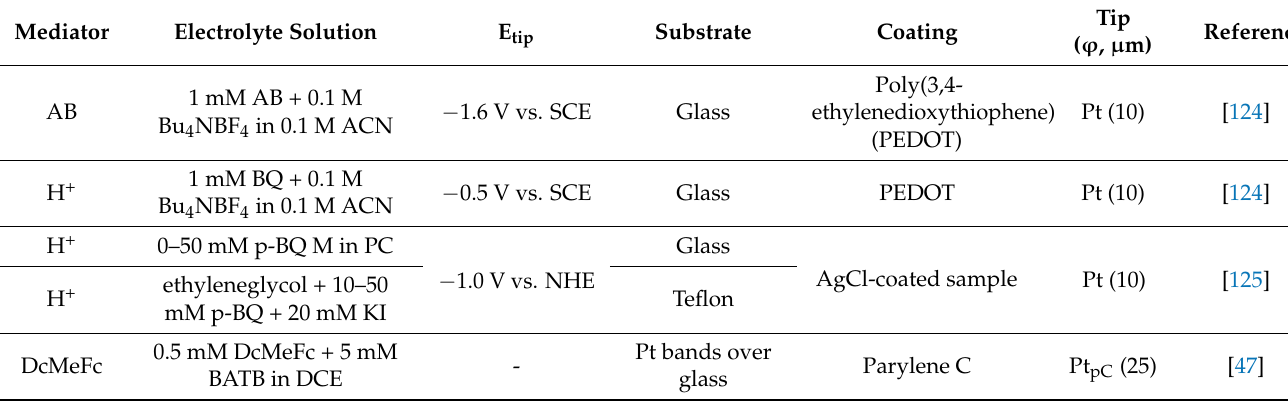
Table 5. Redox mediators used in SECM feedback mode for the characterization of thin surface layers and coatings on